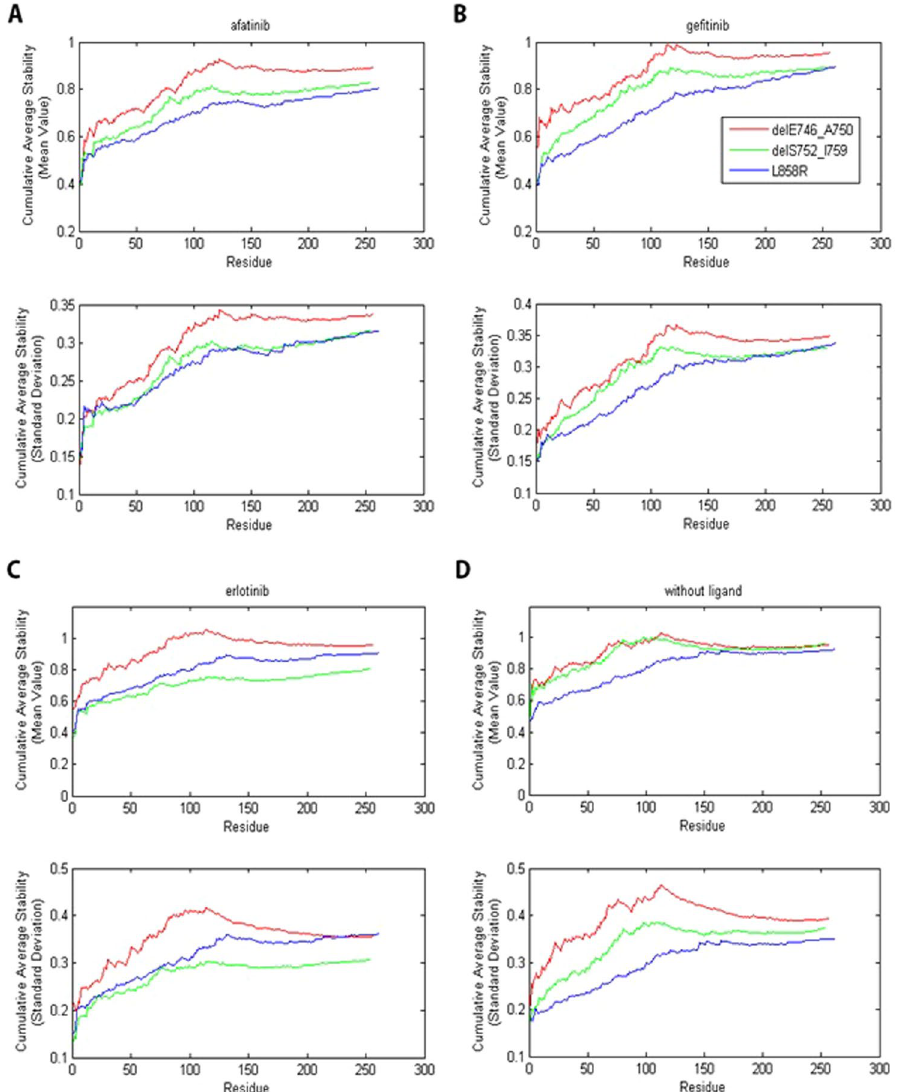
Figure 5. The cumulative average stability for ( A ) EGFR mutant-afatinib complexes, ( B ) EGFR mutant- erlotinib complexes, ( C ) EGFR mutant-gefitinib complexes and ( D ) EGFR mutants without ligand. The cumulative average stability for residue index k corresponded to the average stability of the first k residues closest to the residue